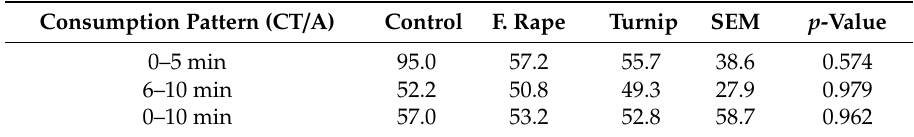
Figure 3. Least squares means ( + Standard Error) of pigs feed intake (a) and palatability expressed as consumption patterns; consumption time/number of approaches to the feeder (b) of corn–soybean base diets with the inclusion of 15% of kale, swede, or wheat middlings (control) when animals were offered one consumption option during 10 min.